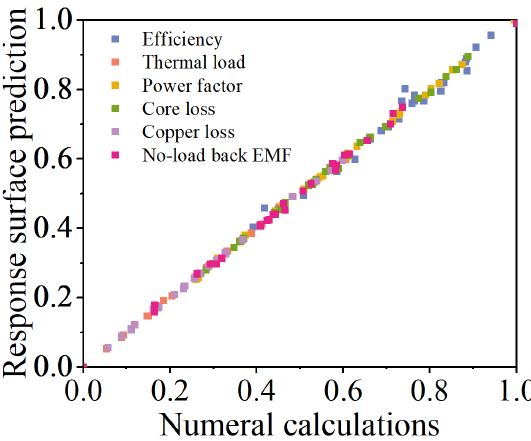
Figure 5. Fitted curve of the predicted and calculated values of the response surface.